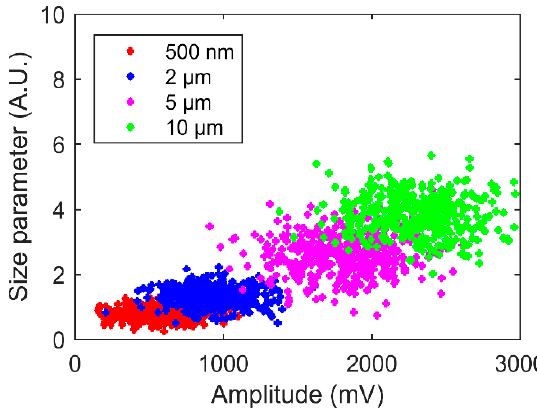
Figure 7. Correlation dot pilot of the PS beads detection. with different particle diameters: 500 nm (red); 2 μ m (blue); 5 μ m (pink); 10 μ m (green).